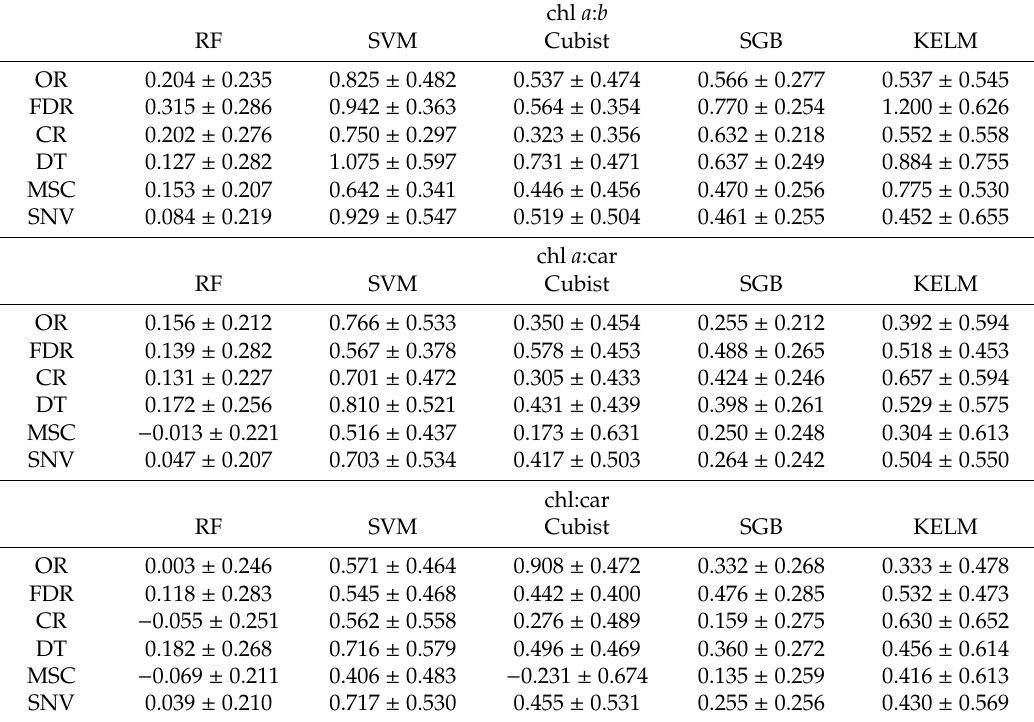
Table 5. Di ff erences in RPD values between the directed estimations and calculated values from estimated chl a , b , and car after 100 repetitions. Positive mean values mean the direct estimation was superior to the indirect